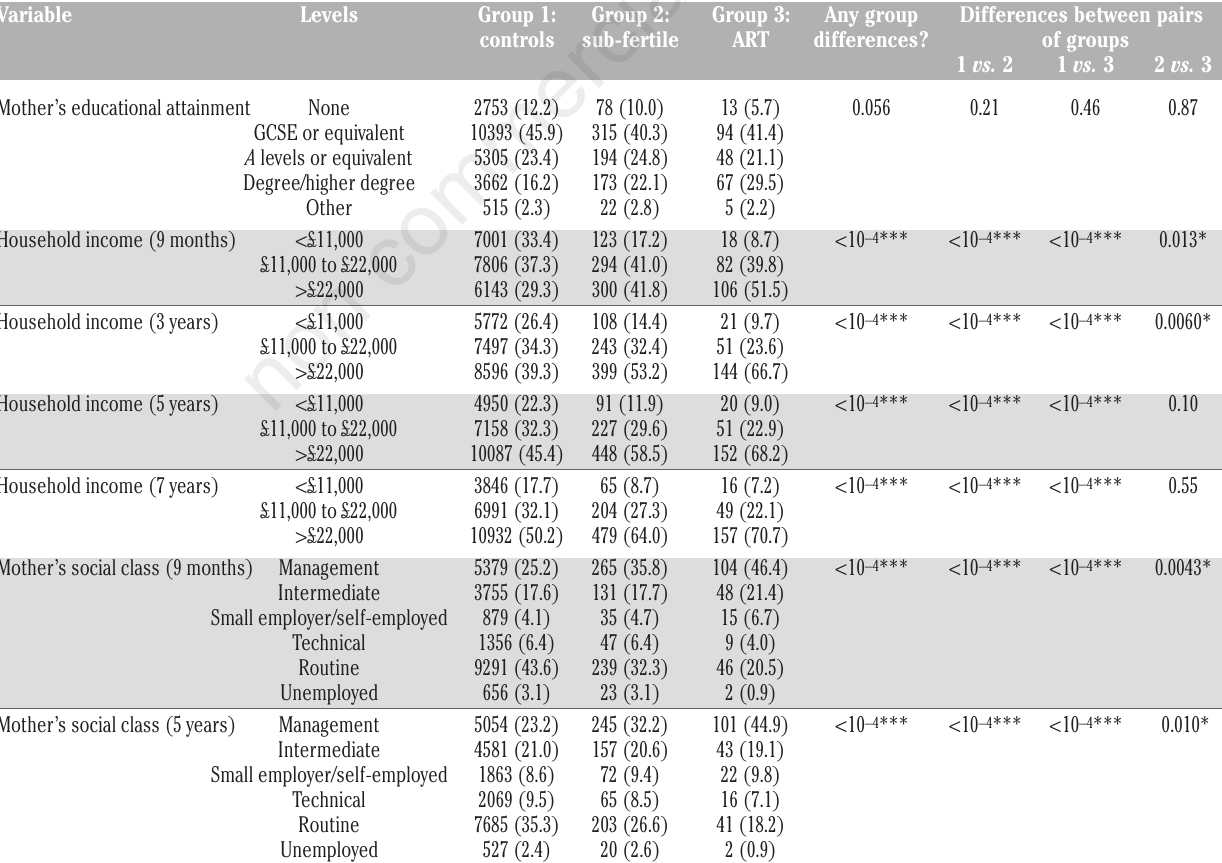
Table 4. Summary of comparisons of categorical covariates by group (II). Numbers of cases are given, with the percentage of the group this represents in brackets. The P for a chi-square test for group differences is given, along with the P for post hoc tests for differences between each pair of groups, using a Bonferroni correction to maintain the Type I error rate of 5%.